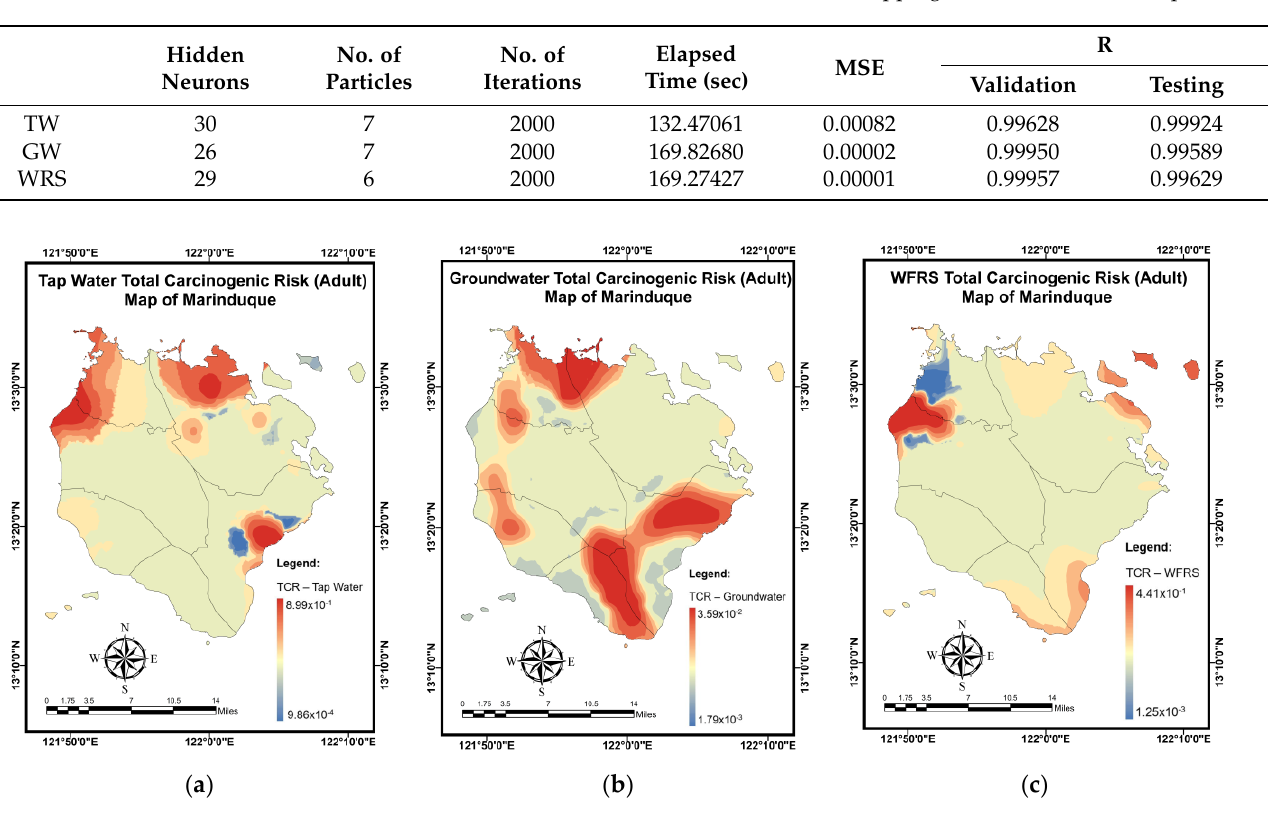
Table 16. NN-PSO simulation results for the TCR (children) mapping of domestic water